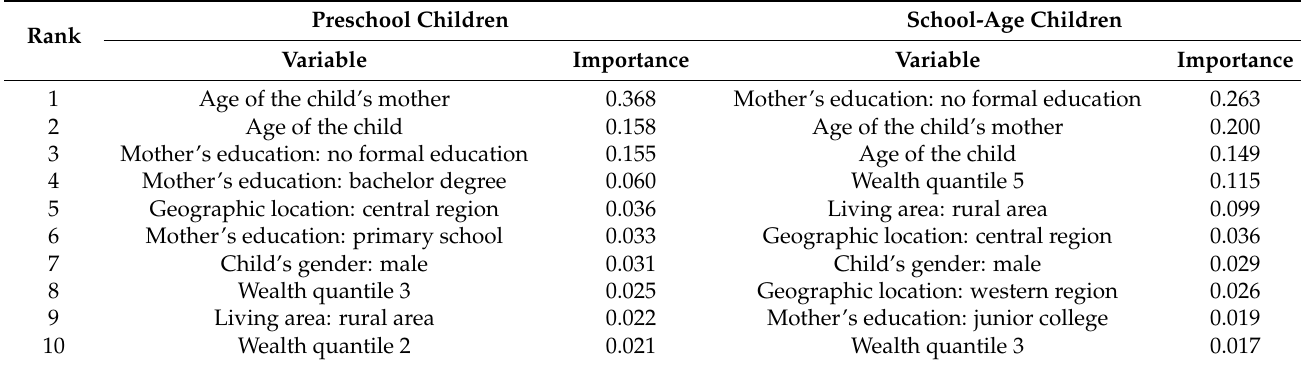
Figure 3. Estimated individual treatment effects of school-age children.